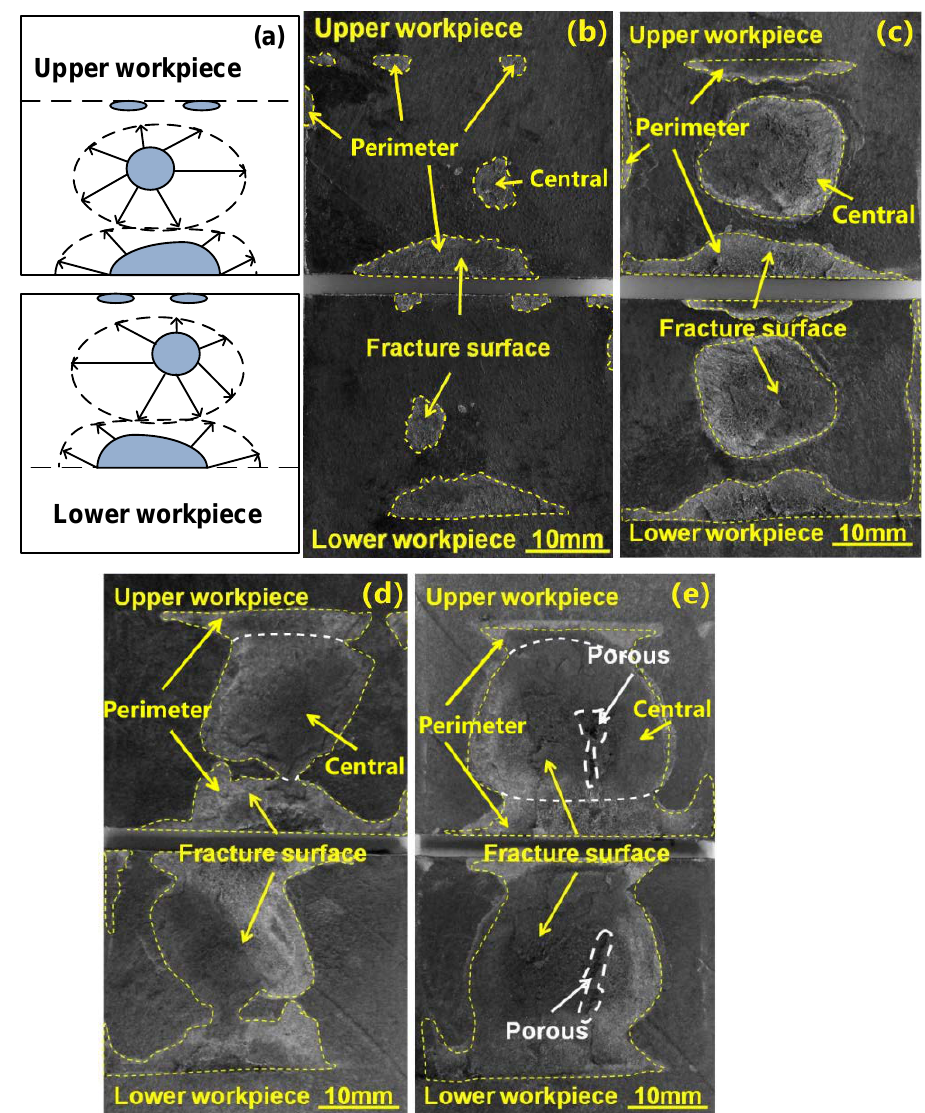
Figure 8. Schematic of weld growth with PPRC ( a ), and weld appearance at various welding times ( b ) 0.5 s, ( c ) 0.9 s, ( d ) 1.3 s, ( e ) 2.1 s.